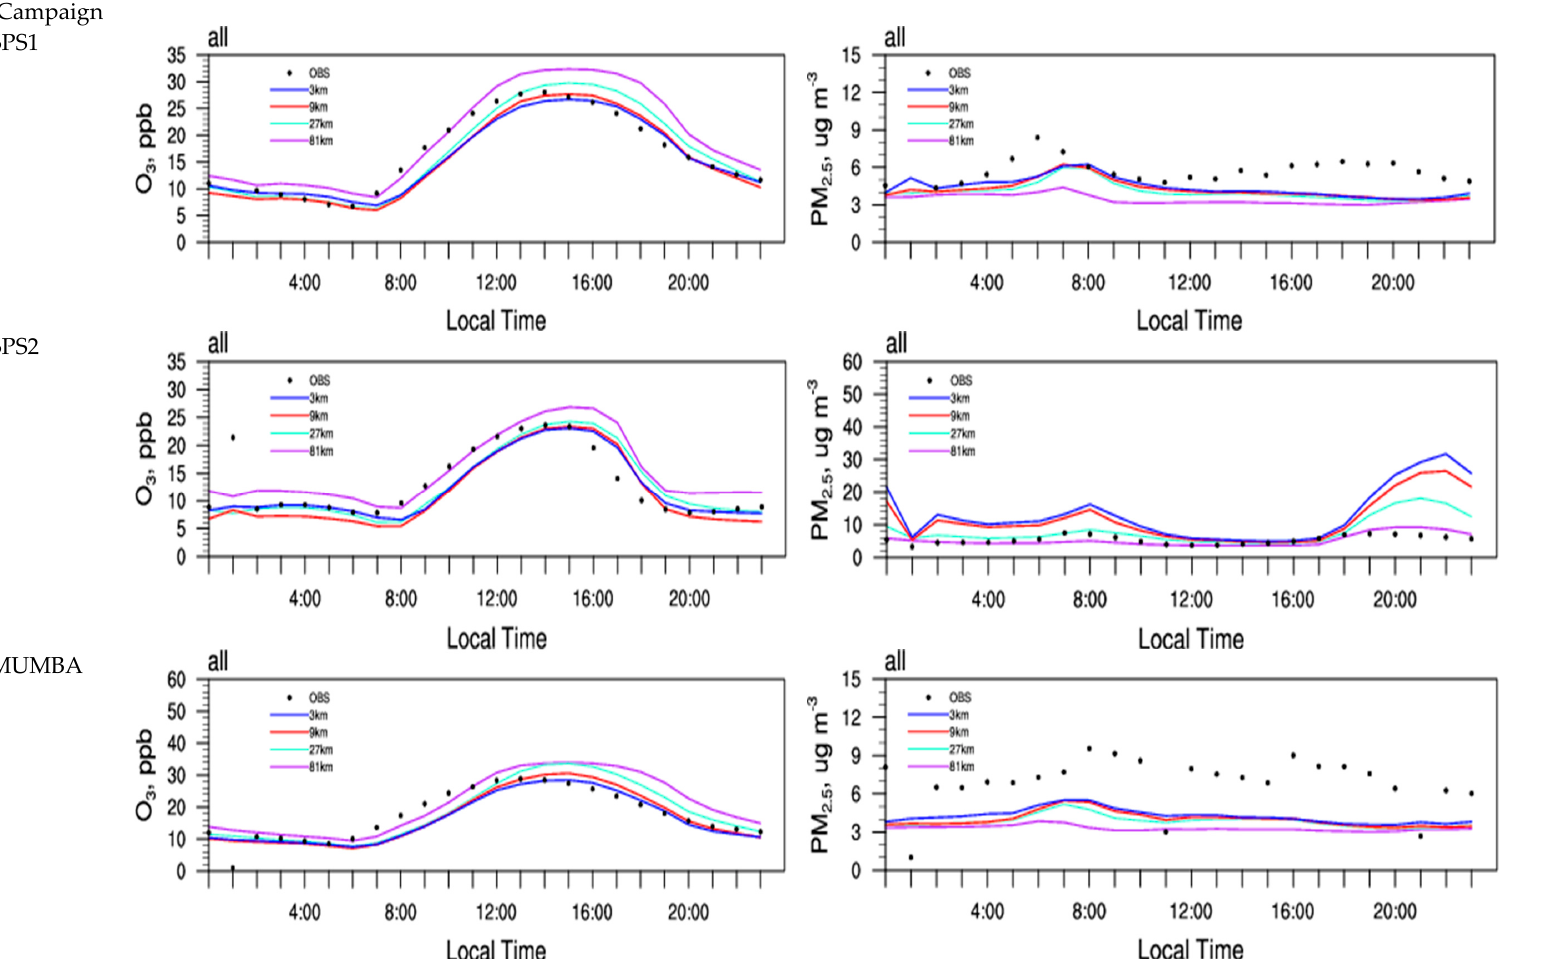
Figure 4. Observed and simulated diurnal profiles of surface concentrations of O 3 and PM 2.5 averaged over all monitoring stations over the Greater Sydney (d04). All simulation results are based on WRF/Chem-ROMS.